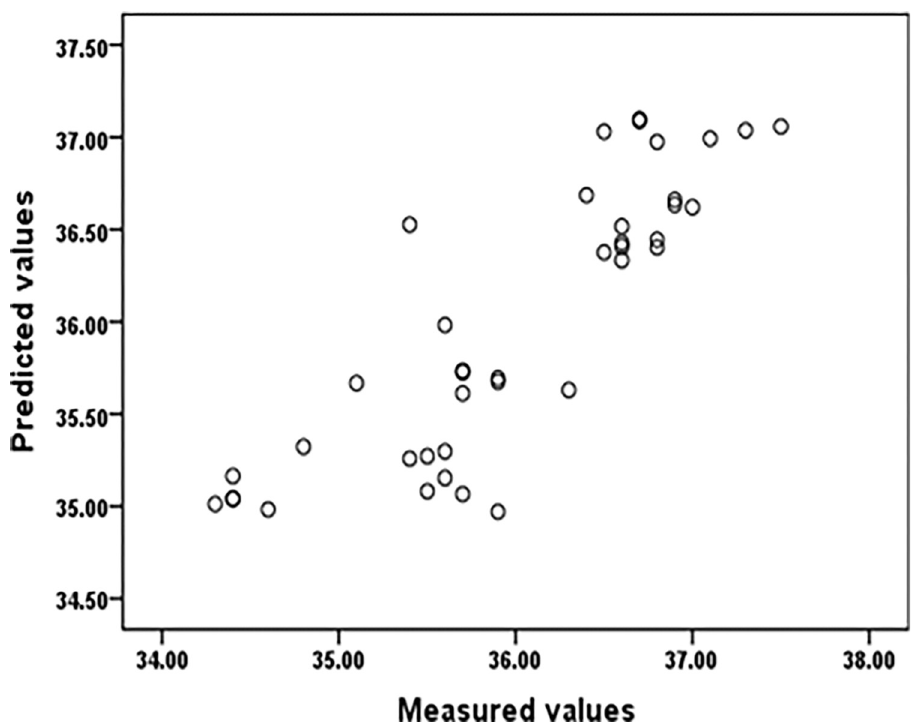
Fig 6. The ear temperature (ET) measured values compared to the predicted values based on LMM.